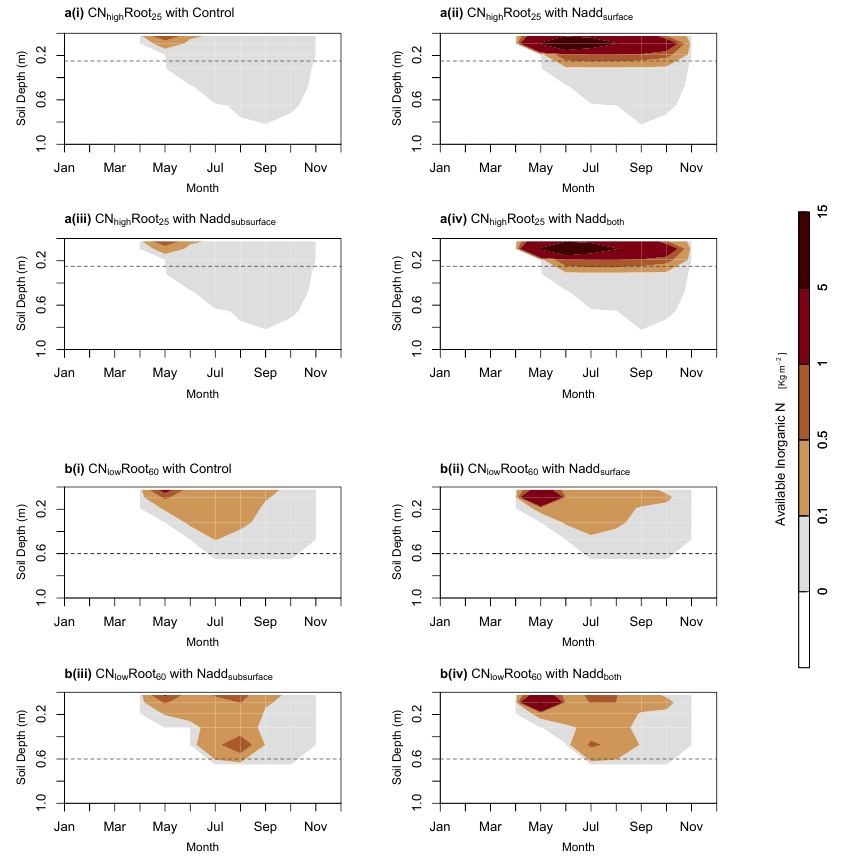
Figure 4. Inorganic nitrogen available to plant species with ( a ) CN high Root 25 (shallow 25 cm roots) and ( b ) CN low Root 60 (deep 60 cm roots) throughout the year 2010 for the four different fertilisation simulations: ( i ) Control , ( ii ) near-surface soil nitrogen fertilisation— N + , ( iii ) fertilisation at NearSurface the thaw front— N + , and ( iv ) both near-surface and thaw-front fertilisation— N + . Dashed ThawFront Both lines indicate the maximum depths of the roots. Grey shading indicates the times and depth of the thawed